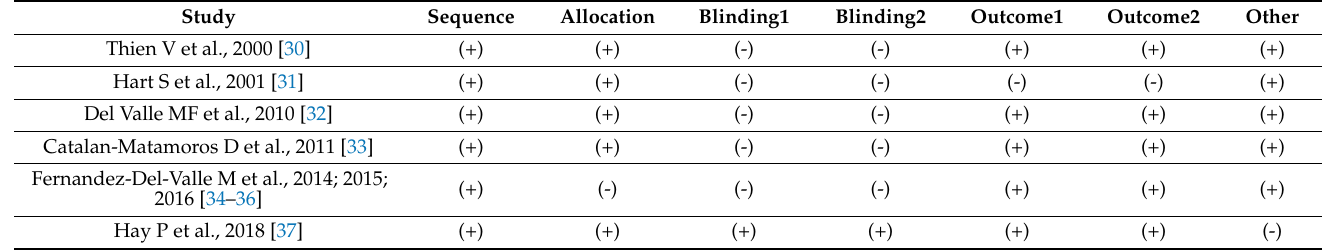
Table 2. Risk of bias. Cochrane Collaboration’s tool for assessing risk of bias [28].